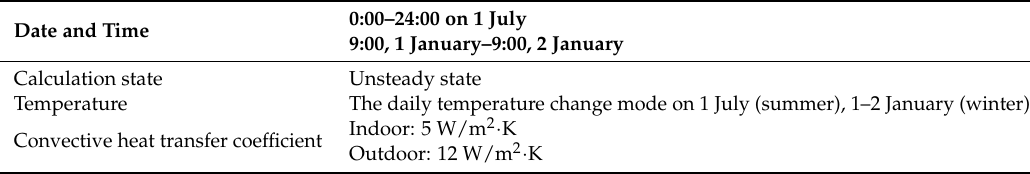
Table 4. The step 2 analysis